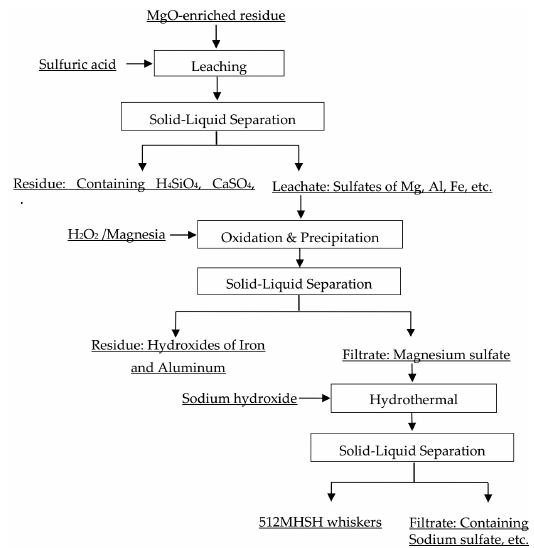
Figure 3. Experimental flow sheet for preparing magnesium hydroxide sulfate hydrate (MHSH) whiskers by using MgO-enriched residue.